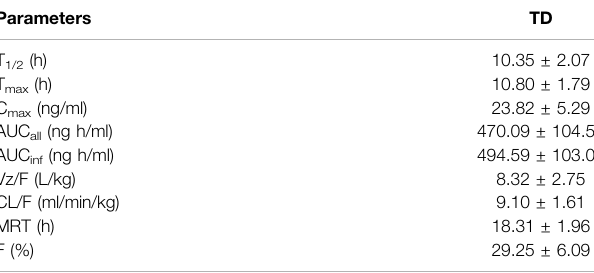
TABLE 9 | Kinetic parameters of BCP in rats after topical dermal